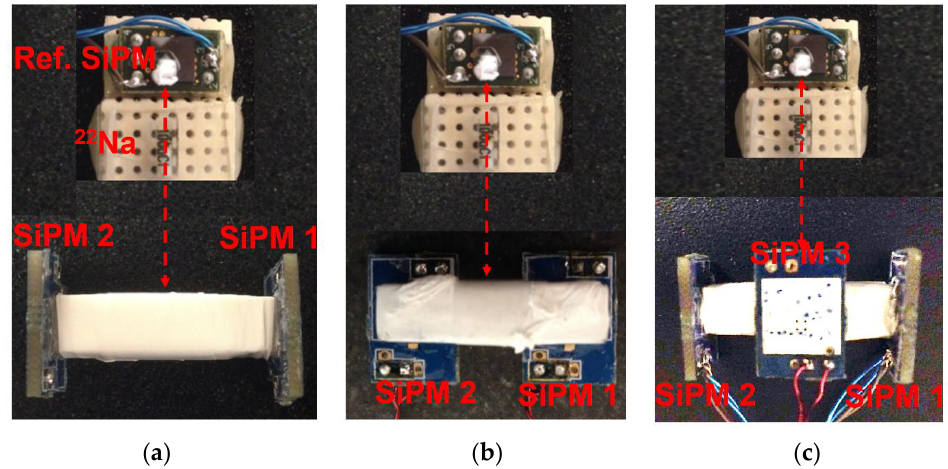
Figure 3. Coincidence experiment, ( a ) dual-ended readout, ( b ) side dual-ended readout, and ( c ) triple-ended readout.